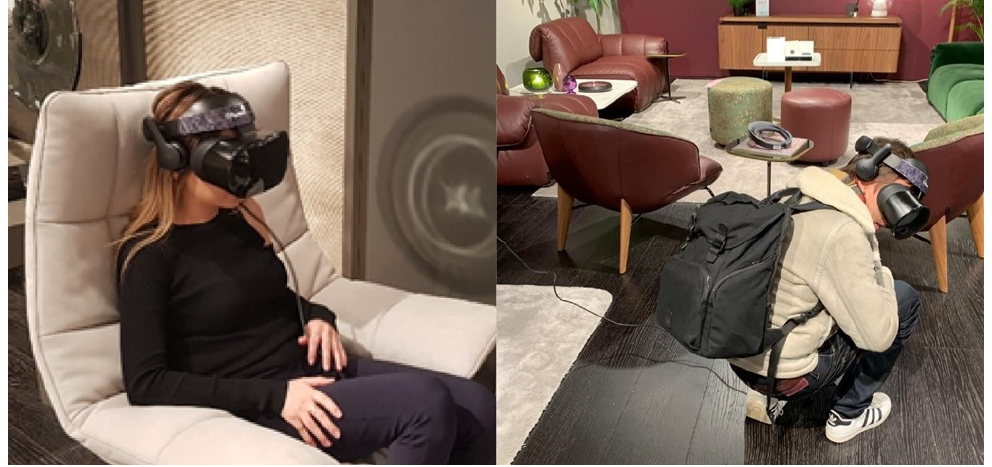
Figure 1. Our novel Multi-Sensory in-Store Virtual Reality Customer Journey: starting from a safer seated position, once confident, the customer can stand up and explore the product configuration.